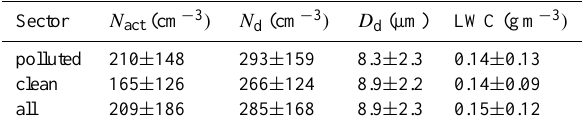
Table 3. Average values and standard deviations of number con- centration of activated particles ( N act , calculated as the concentra- tion difference between the total and interstitial lines), cloud droplet number concentration ( N d ) , droplet diameter ( D d ) and liquid water content (LWC) in cloudy conditions for the sectors with and without local pollutant sources and for the whole data